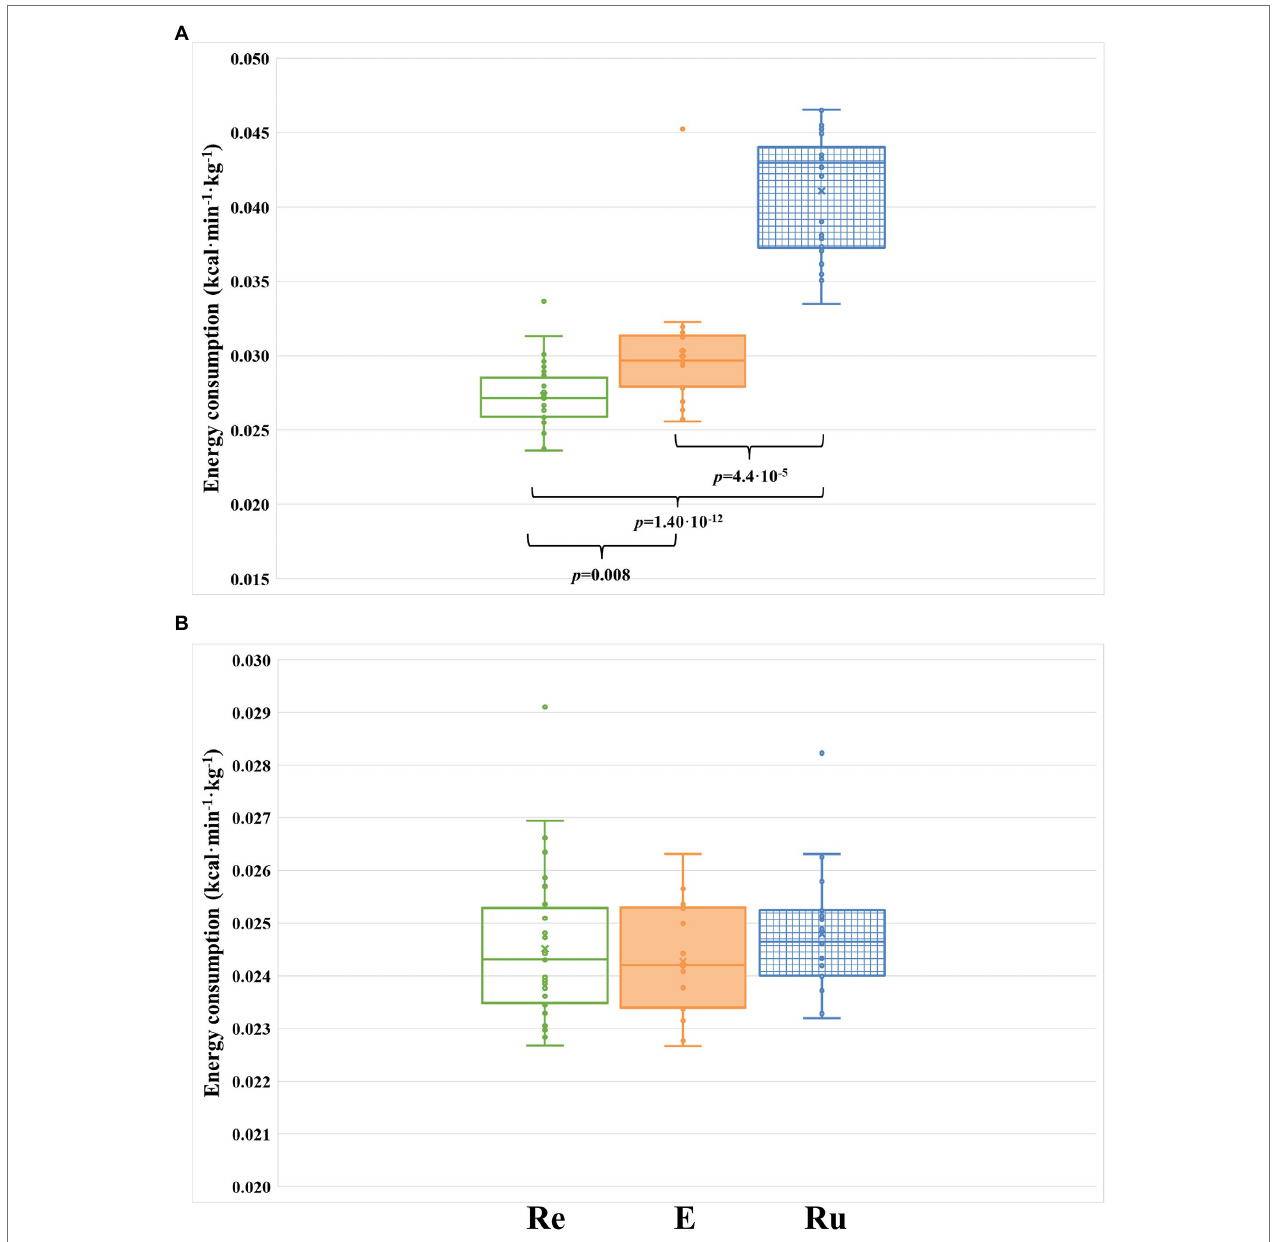
FIGURE 3 | Comparison of energy consumption (kcal/kg/min) between the three groups during the intervention phase of the study. (A) Energy consumed by each group during the three 8-h segments where the recovery activity was performed (24 h in total). (B) Energy consumed by each group during the time of the intervention phase where runners are not performing the activity (13 8-h segments). Re, participants included in the REST group (green-rimmed boxes); E, participants included in the ELLIPTICAL group (orange-filled boxes); and Ru, participants included in the RUN group (blue-dashed